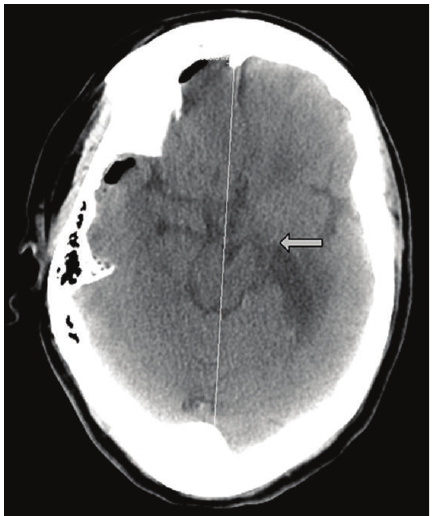
Figure 2: CT of the head after craniotomy and evacuation of subdu- ral hematoma showing persistent midline shift of the midbrain with deformity of crus cerebri (marked by arrow).